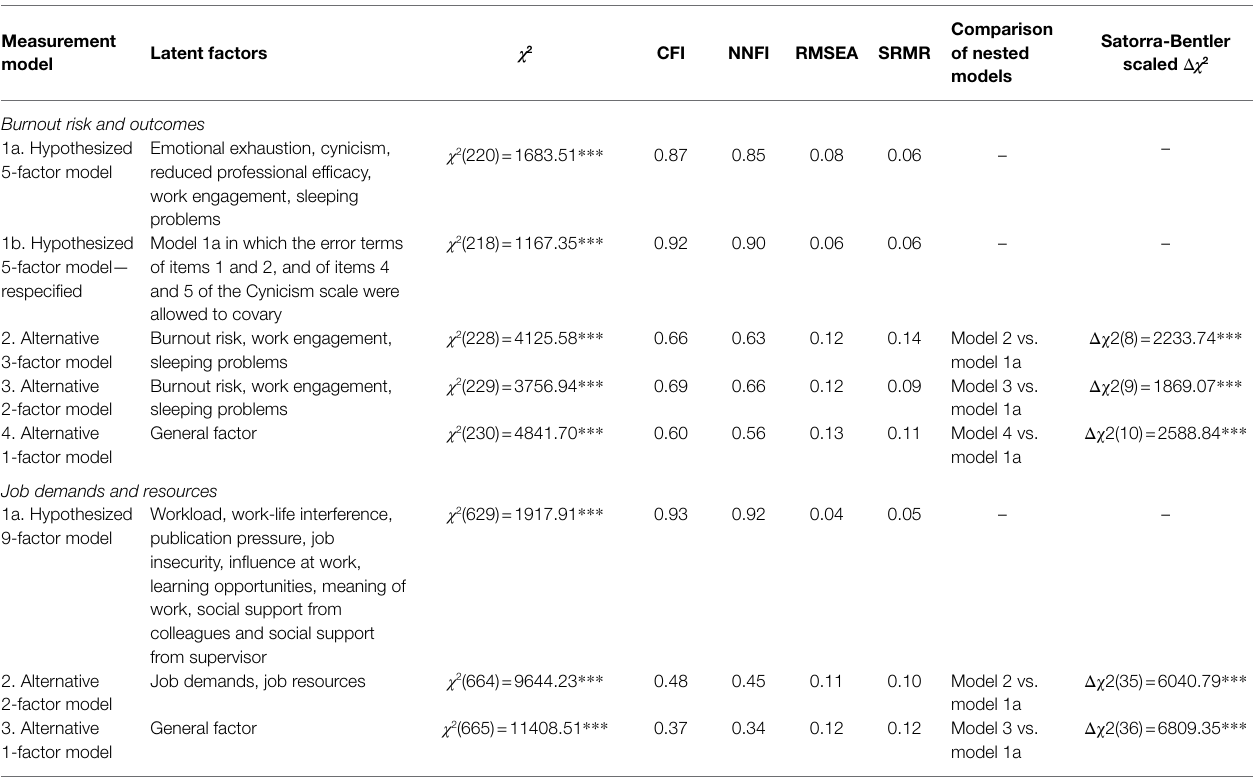
TABLE 2 | Results of the confirmatory factor